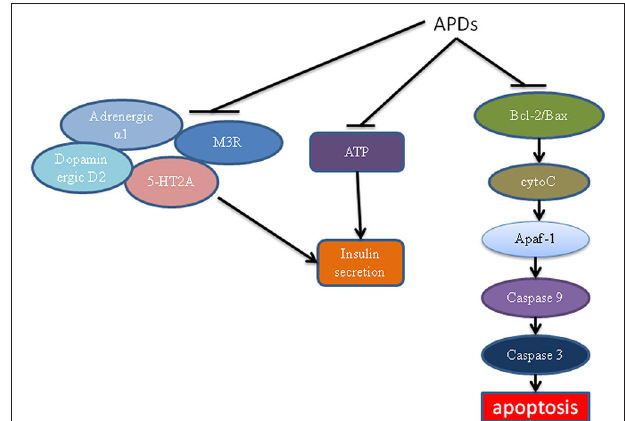
FIGURE 3 | The effects of antipsychotics on β -cells. Antipsychotics can block ATP and M3, adrenergic α 1 and 5-HT2A receptor-mediated insulin secretion. APDs act on the mitochondrial apoptotic pathway, leading to decreased Bcl-2 ratio, increased cytochrome c release, Apaf/caspase activation and apoptosis. APDs, antipsychotic drugs; ATP, adenosine triphosphate; M3R, muscarinic M3 receptor; Apaf, apoptotic protease activating